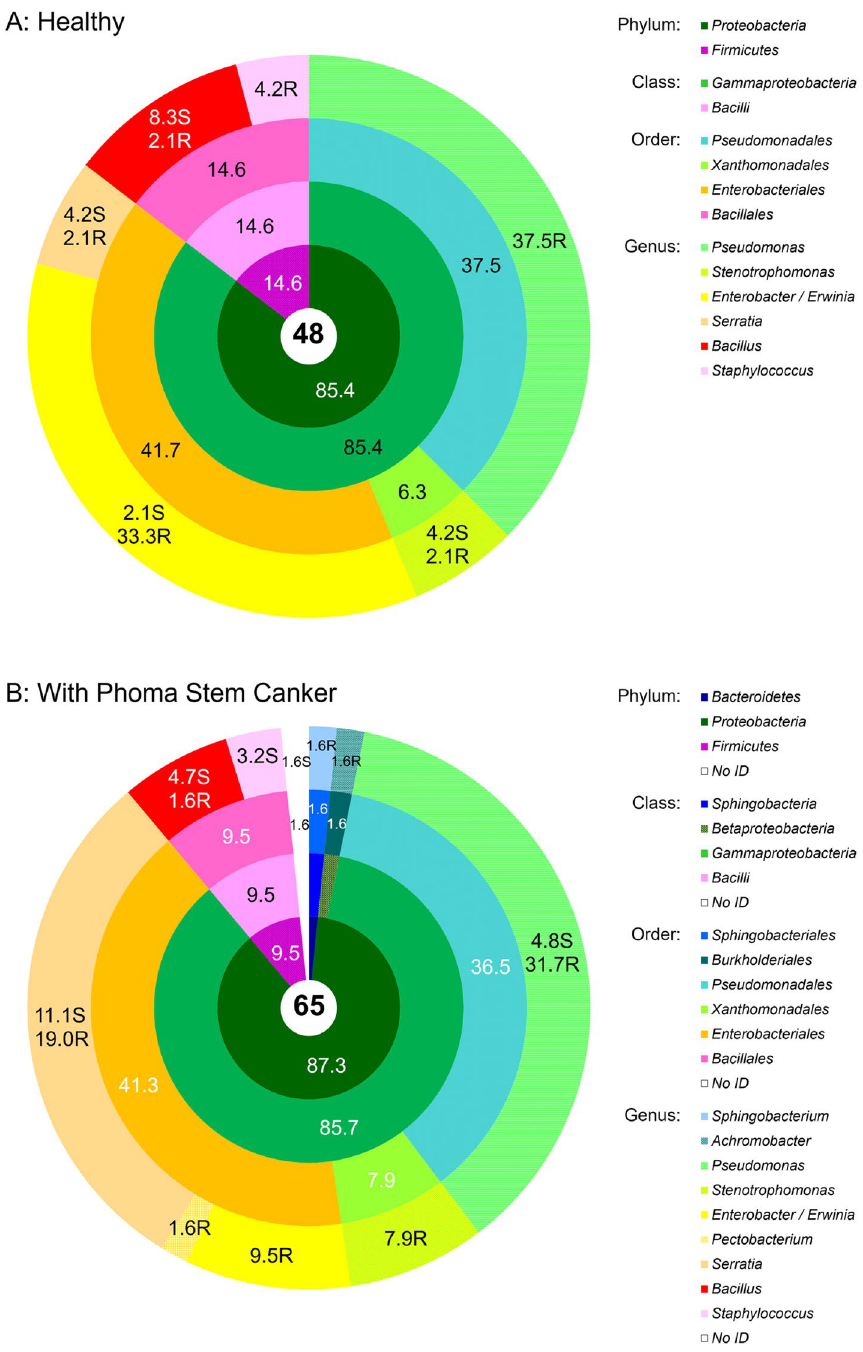
Figure 2. Community composition of the cultivable bacterial endophytic community associated with symptomless oilseed rape (A) and oilseed rape showing symptoms of Phoma Stem Canker (B) . The total number of isolates in each group is shown in the central circle. The chart shows percentages by phyla, classes, orders, and genera progressively from the central to the outermost annuli. N.D. not determined. On the genus level, the abundances of isolates from roots and shoots are presented separately, with the additional letters “R” for roots, and “S” for shoots. Systematic classification according to 49